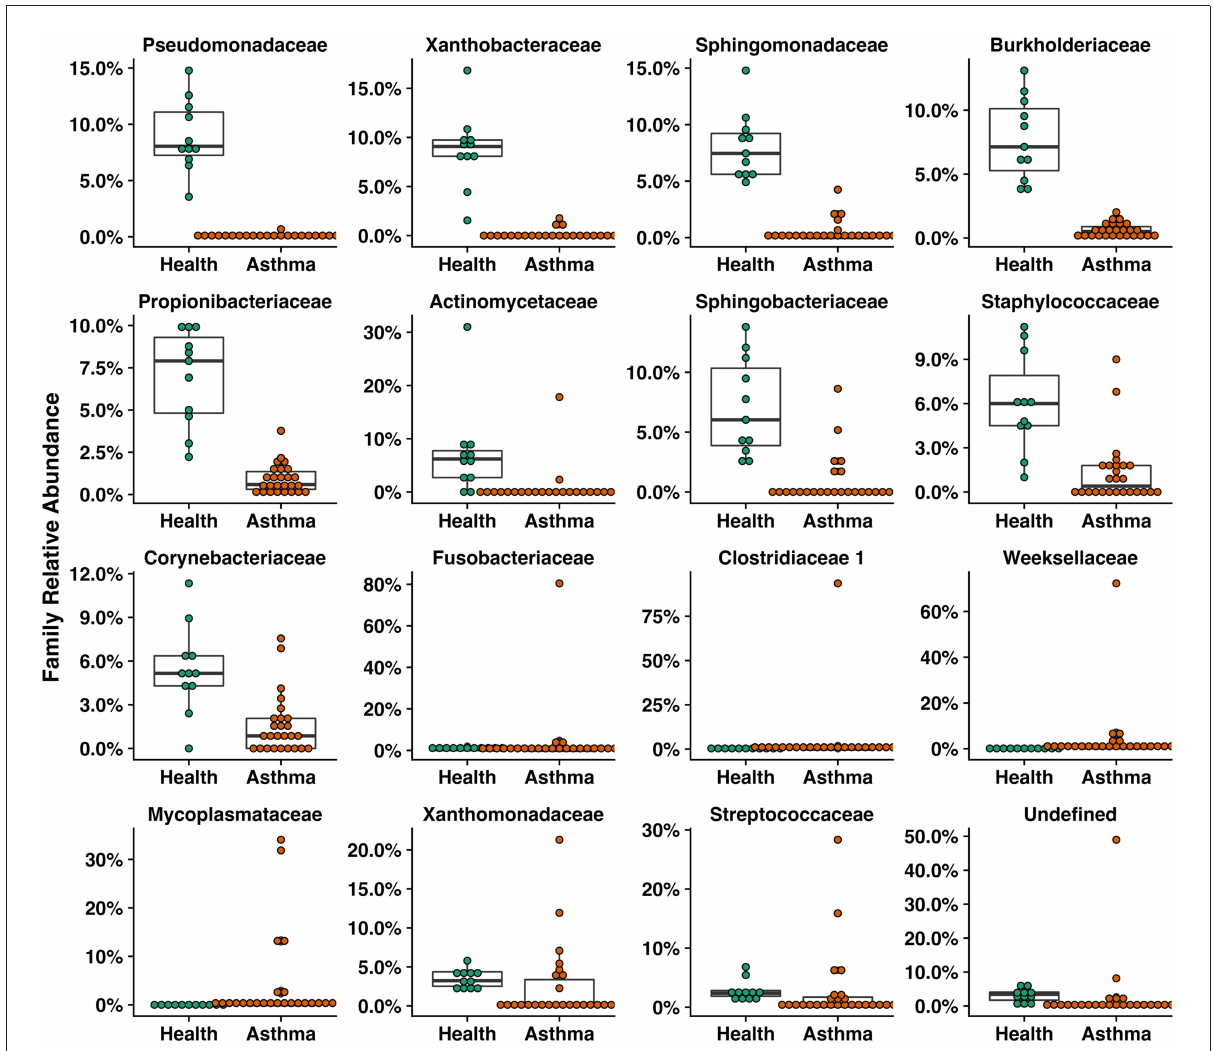
FIGURE5 Box plots of families that were significantly different including those with a greater than two-fold change or were significantly different in healthy compared to asthmatic pet cats.